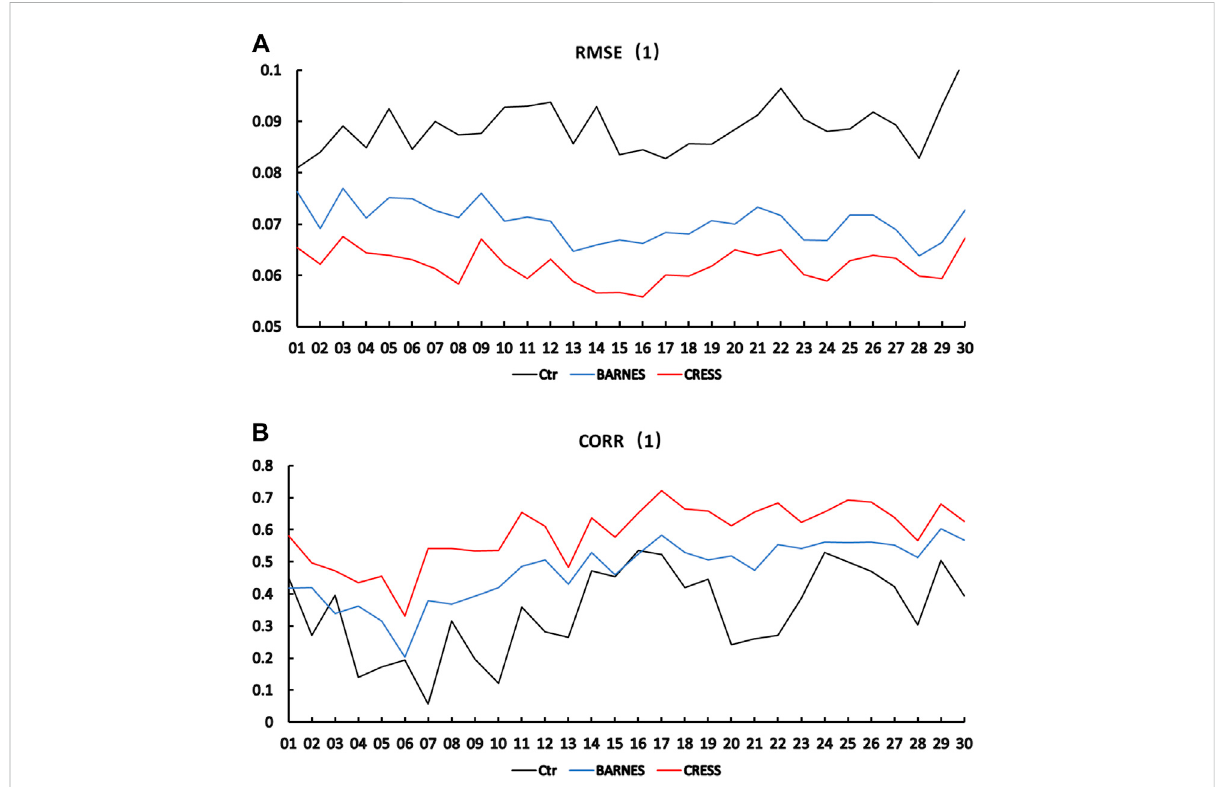
FIGURE 7 DailyRMSEs (A) andCorrs (B) betweenSMAP andproducts ofeachexperimentfrom1Septemberto 1October 2020,includingCtr(blacklines), BARNES (blue lines), and CRESS (red lines).